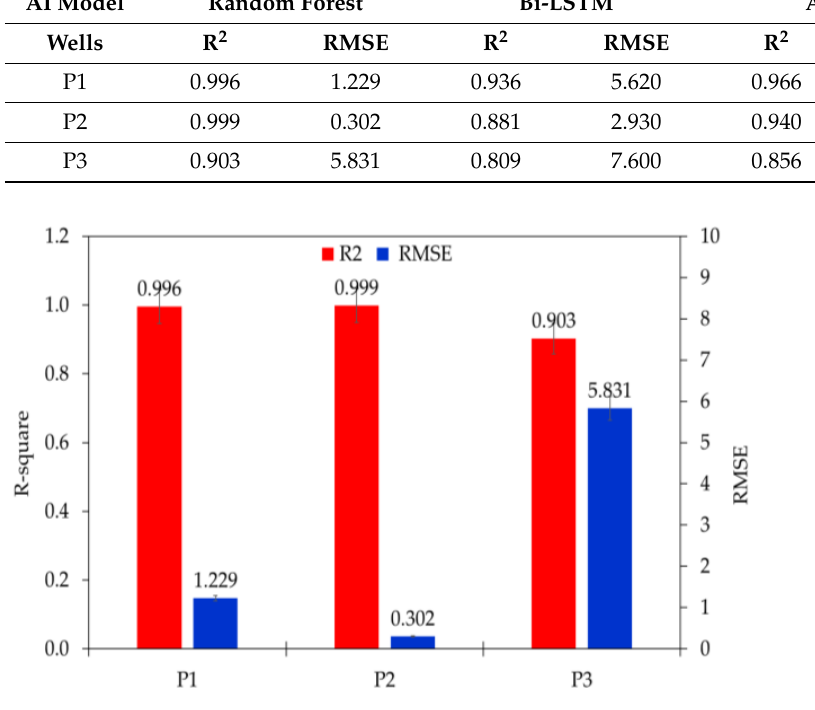
Figure 9. Single-well prediction using RF.